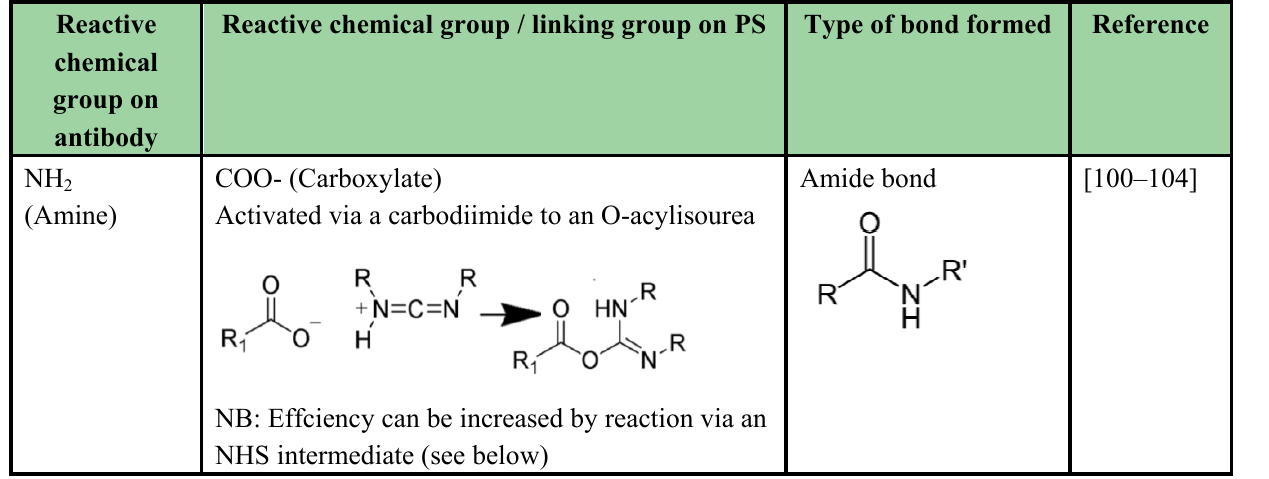
Table 3. Some common chemical linkages for antibody targeted PDT. Common types of chemical linkages that have been used to covalently attach PS-drugs to antibodies or antibody fragments